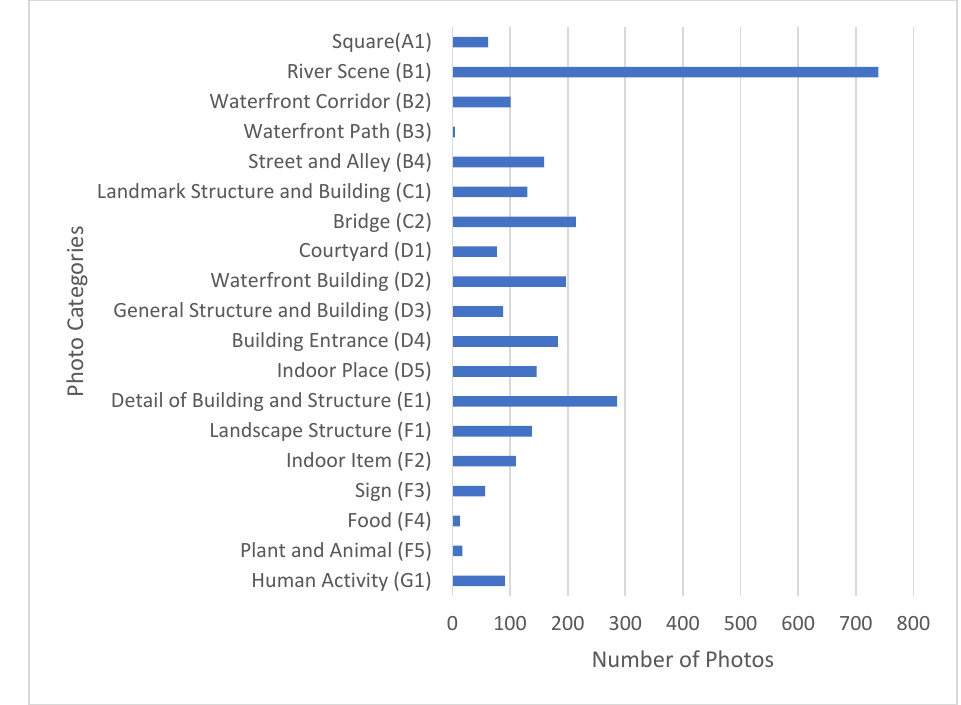
Figure 10. The categories and frequency statistics of the contents of travel photos (source: authors).